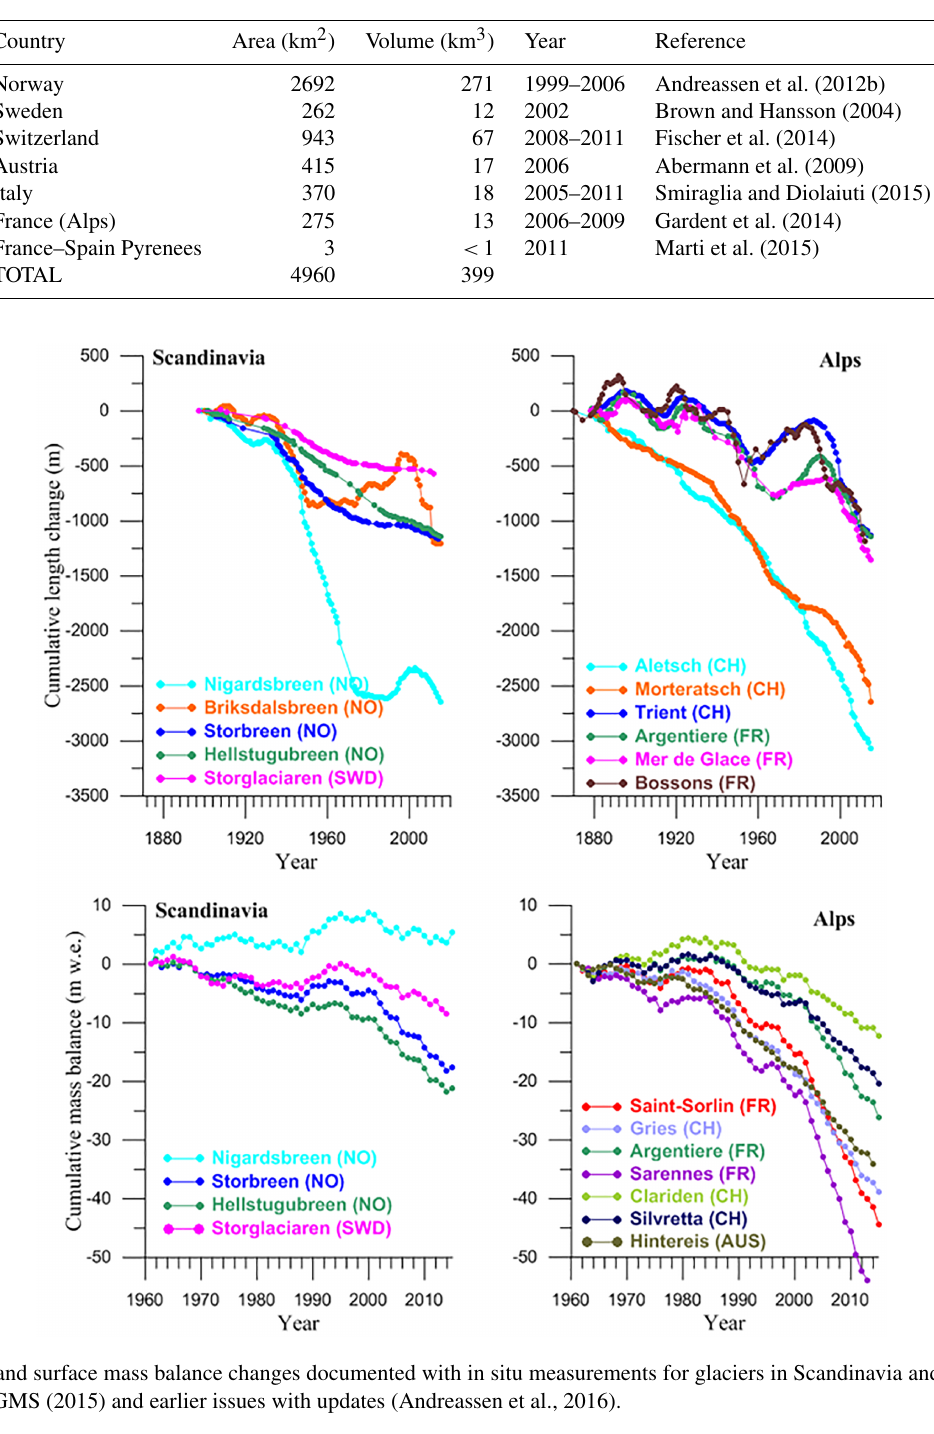
Table 2. Distribution of glacier area and volume in continental Europe and mainland Scandinavia. Years of reference and respective publica- tions are given for the glacier area. Ice volume estimates refer to 2003 for continental Europe and Sweden (Huss and Farinotti, 2012) and to 1999–2006 for Norway (Andreassen et al., 2015). Uncertainties in ice volume are on the order of 10–20%.